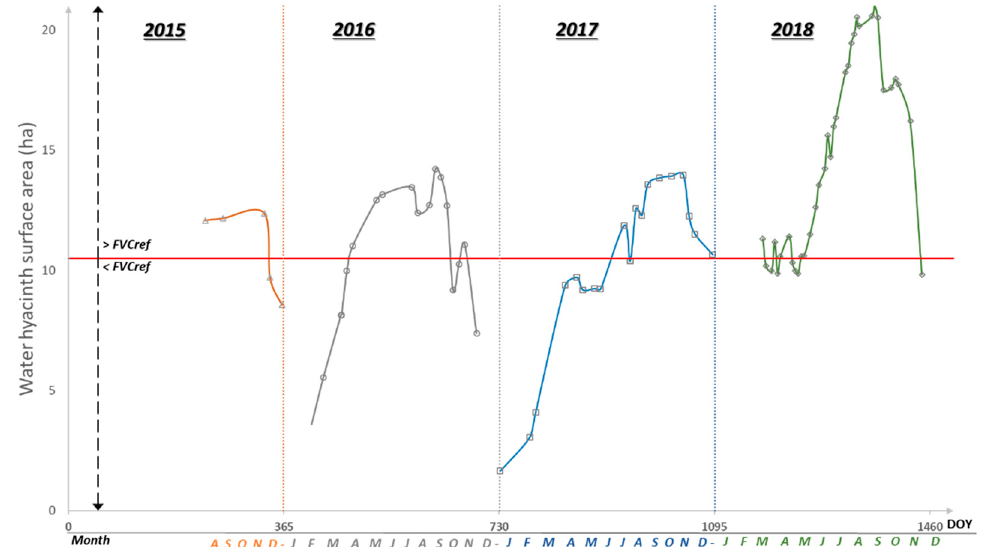
Figure 9. Multi-year dynamics (2015–2018) of the plant surface (ha) in the river corridor. The horizontal red line indicates the FVC threshold of the reference image (FVCref). The areas above this reference value indicate the area of water hyacinth.